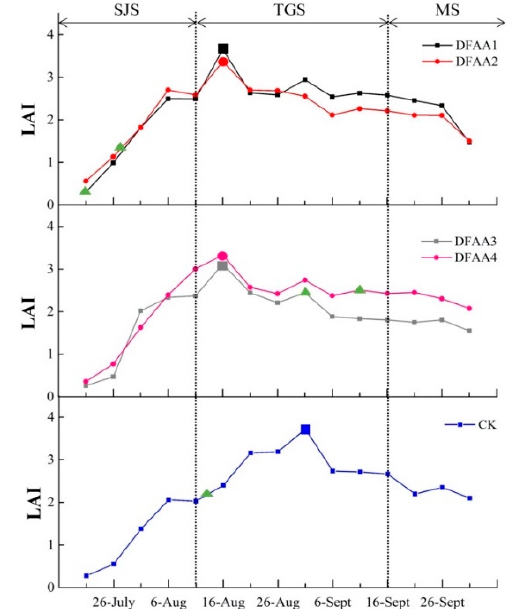
Figure 5. The leaf area index of summer maize in di ff erent growth periods. The green triangles are the time point of rainfall in di ff erent treatments. The thicker points correspond to the maximum leaf area index. LAI represents the leaf area index. SJS represents the seeding-jointing stage, TGS represents the tasseling-grain filling stage, MS represents the mature